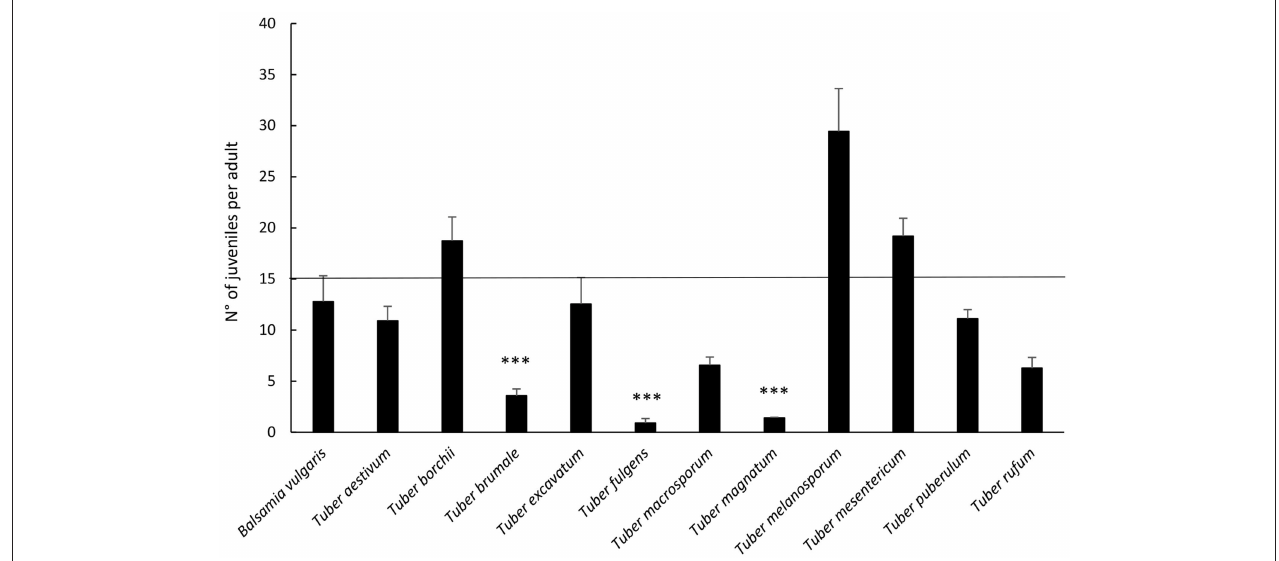
FIGURE 3 | Average percentage ± Standard Error of F. candida juveniles (numbers of juveniles/surviving adults) after 28 days’ feeding on truffles. The horizontal line represents cereal mixture (control). Asterisks correspond to significant differences between truffle and control: * p < 0.05, **0.05 > p > 0.01, *** p < 0.01. For the differences between truffles, see Supplementary Table 1